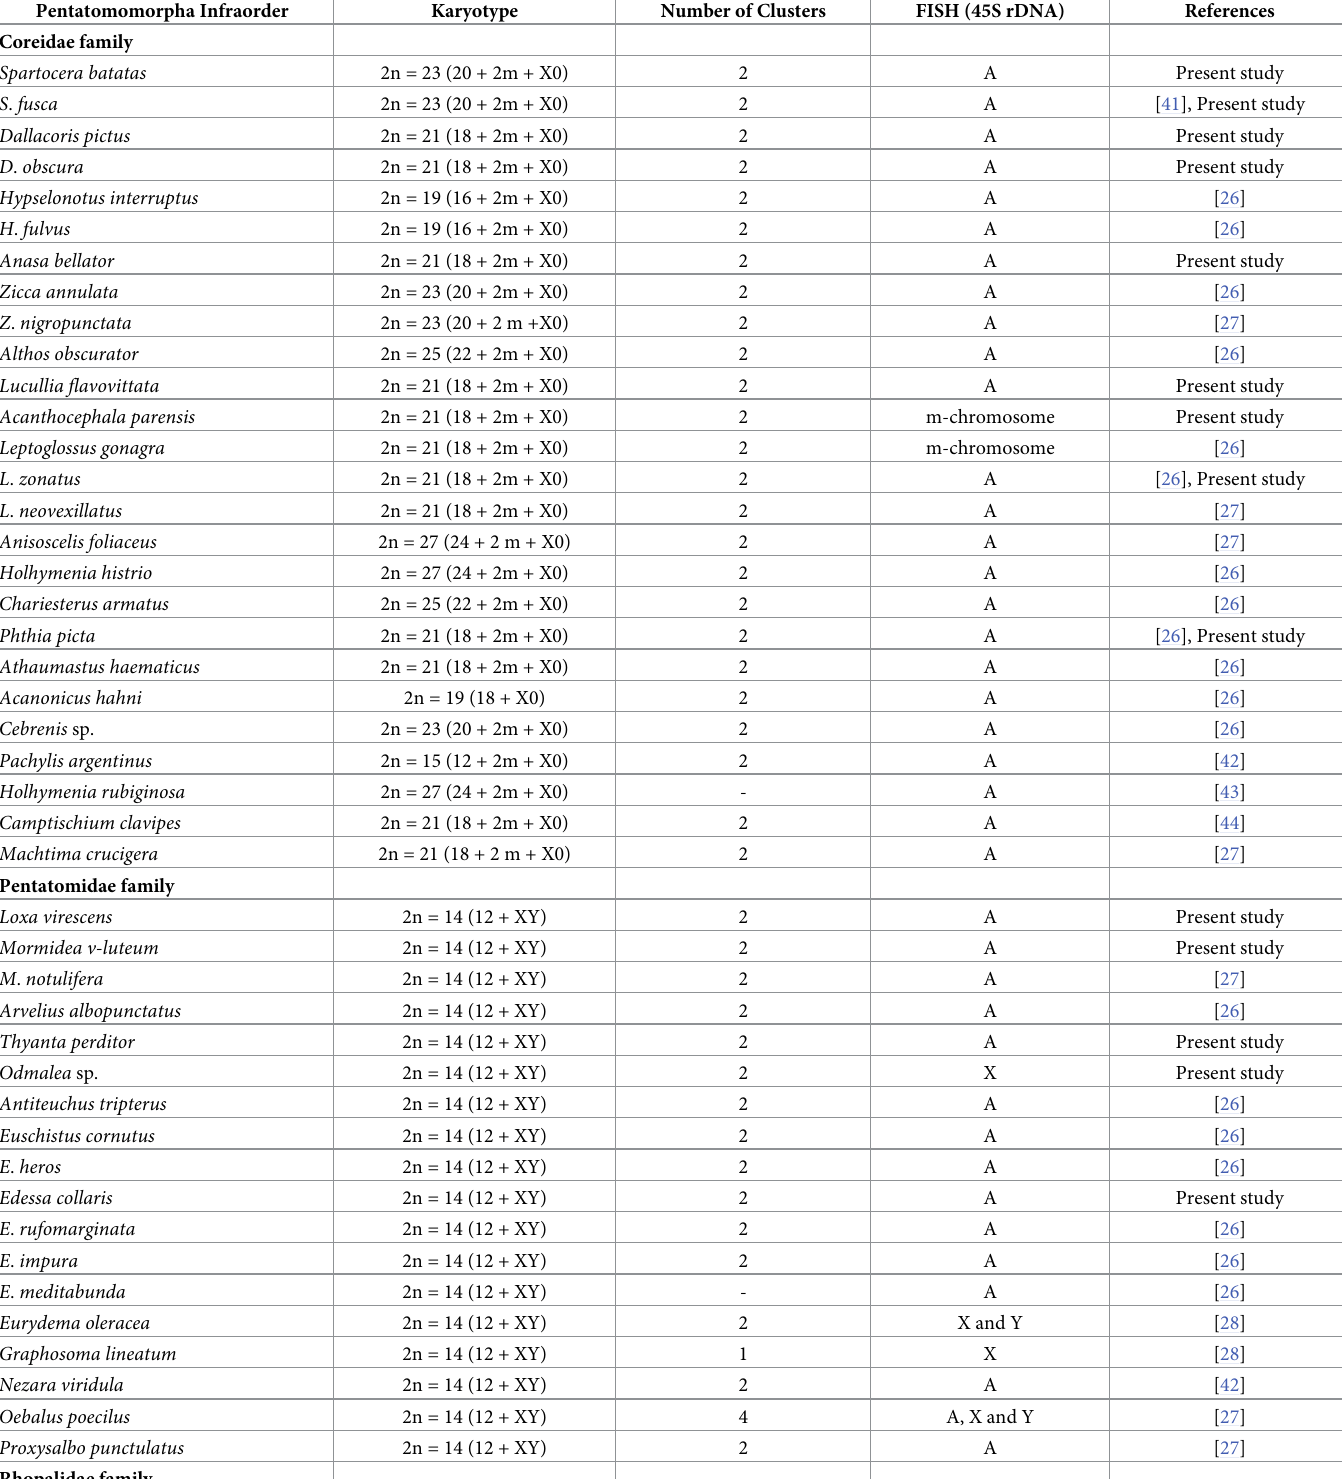
Table 1. Chromosomal complement, number of clusters and chromosomal pair where there was the labeling of 45 rDNA in the infraorder Pentatomomorpha. A: autosomes, X: X sex chromosome, X: Y sex chromosome. Pentatomomorpha